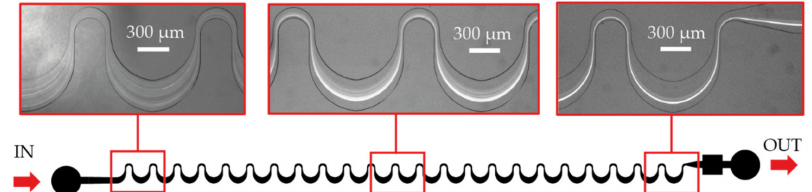
Figure 5. Evolution of the lateral focusing state of 4.8 µ m fluorescent beads through the H25_W cr 50 mi- crofluidic channel from the beginning till the end (23rd